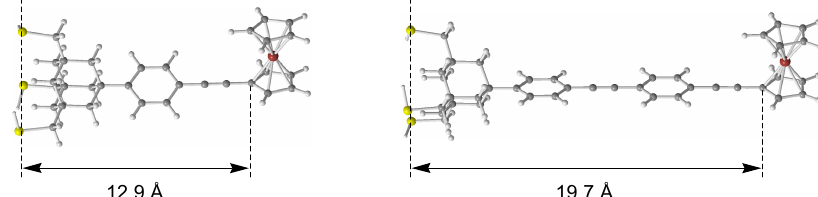
Figure 6. Structures of trithiol 2a ( left ) [20] and 2b ( right ) optimized at the B3LYP/3-21G(d)-LANL2DZ level.